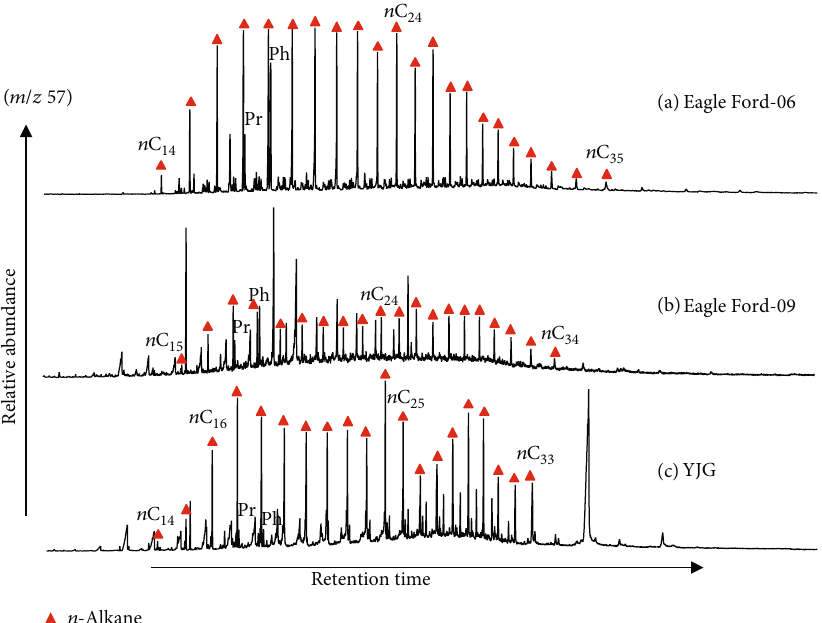
Figure 5: m / z 57 mass chromatograms of the organic compounds in diethyl ether ((a) Eagle Ford-06, (b) Eagle Ford-09, and (c)